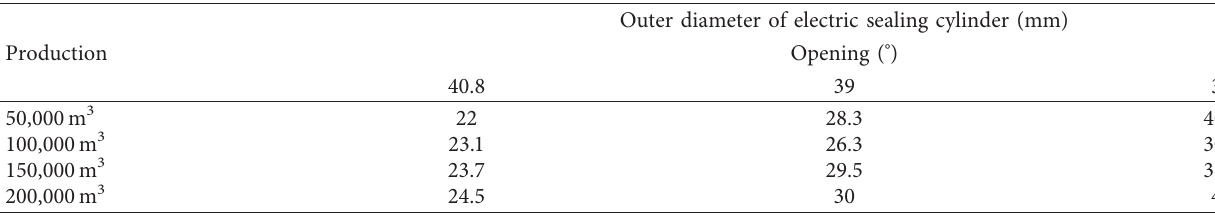
Figure 6: Comparison of annular pressure drop and pressure drop of throttle valve with different openings. (a) 50,000m 3 . (b) 100,000 m 3 . (c) 150,000 m 3 . (d) 200,000 m 3 . Table 4: Critical effective opening of throttle